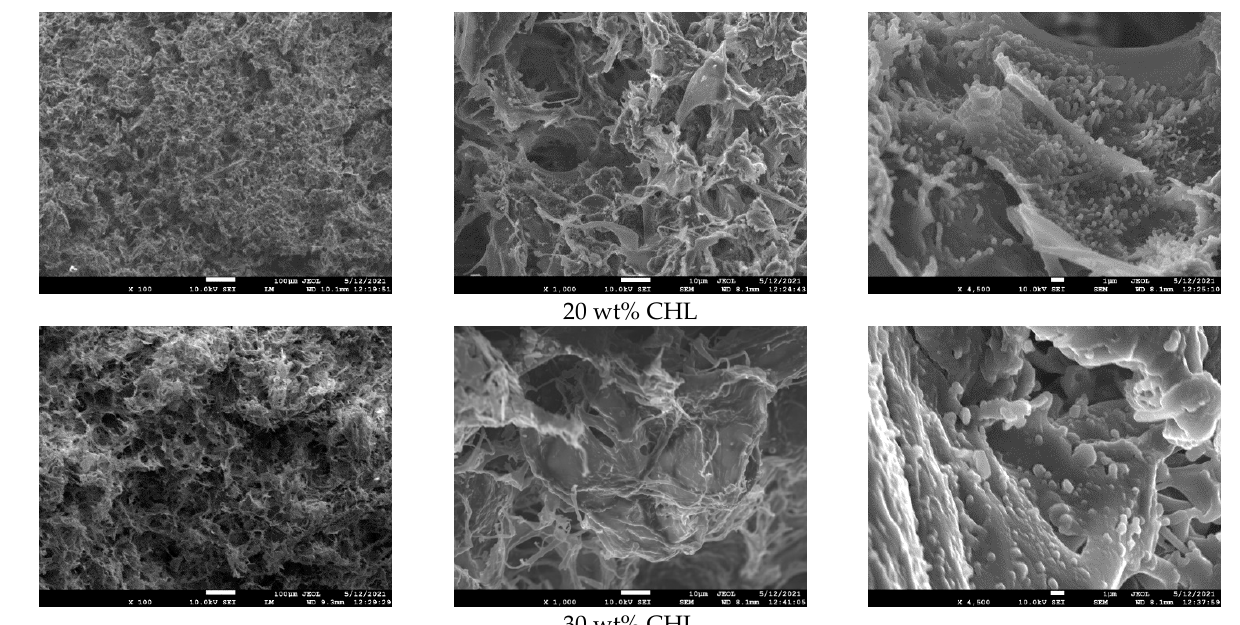
Figure 9. SEM micrographs of and poly(vinyl alcohol) (PVA)/cellulose nanofibrils (CNF) (10 wt%) sponges with and without chloramphenicol (CHL). Table 2. Drug-loading and entrapment efficiency for the chloramphenicol loaded sponges.